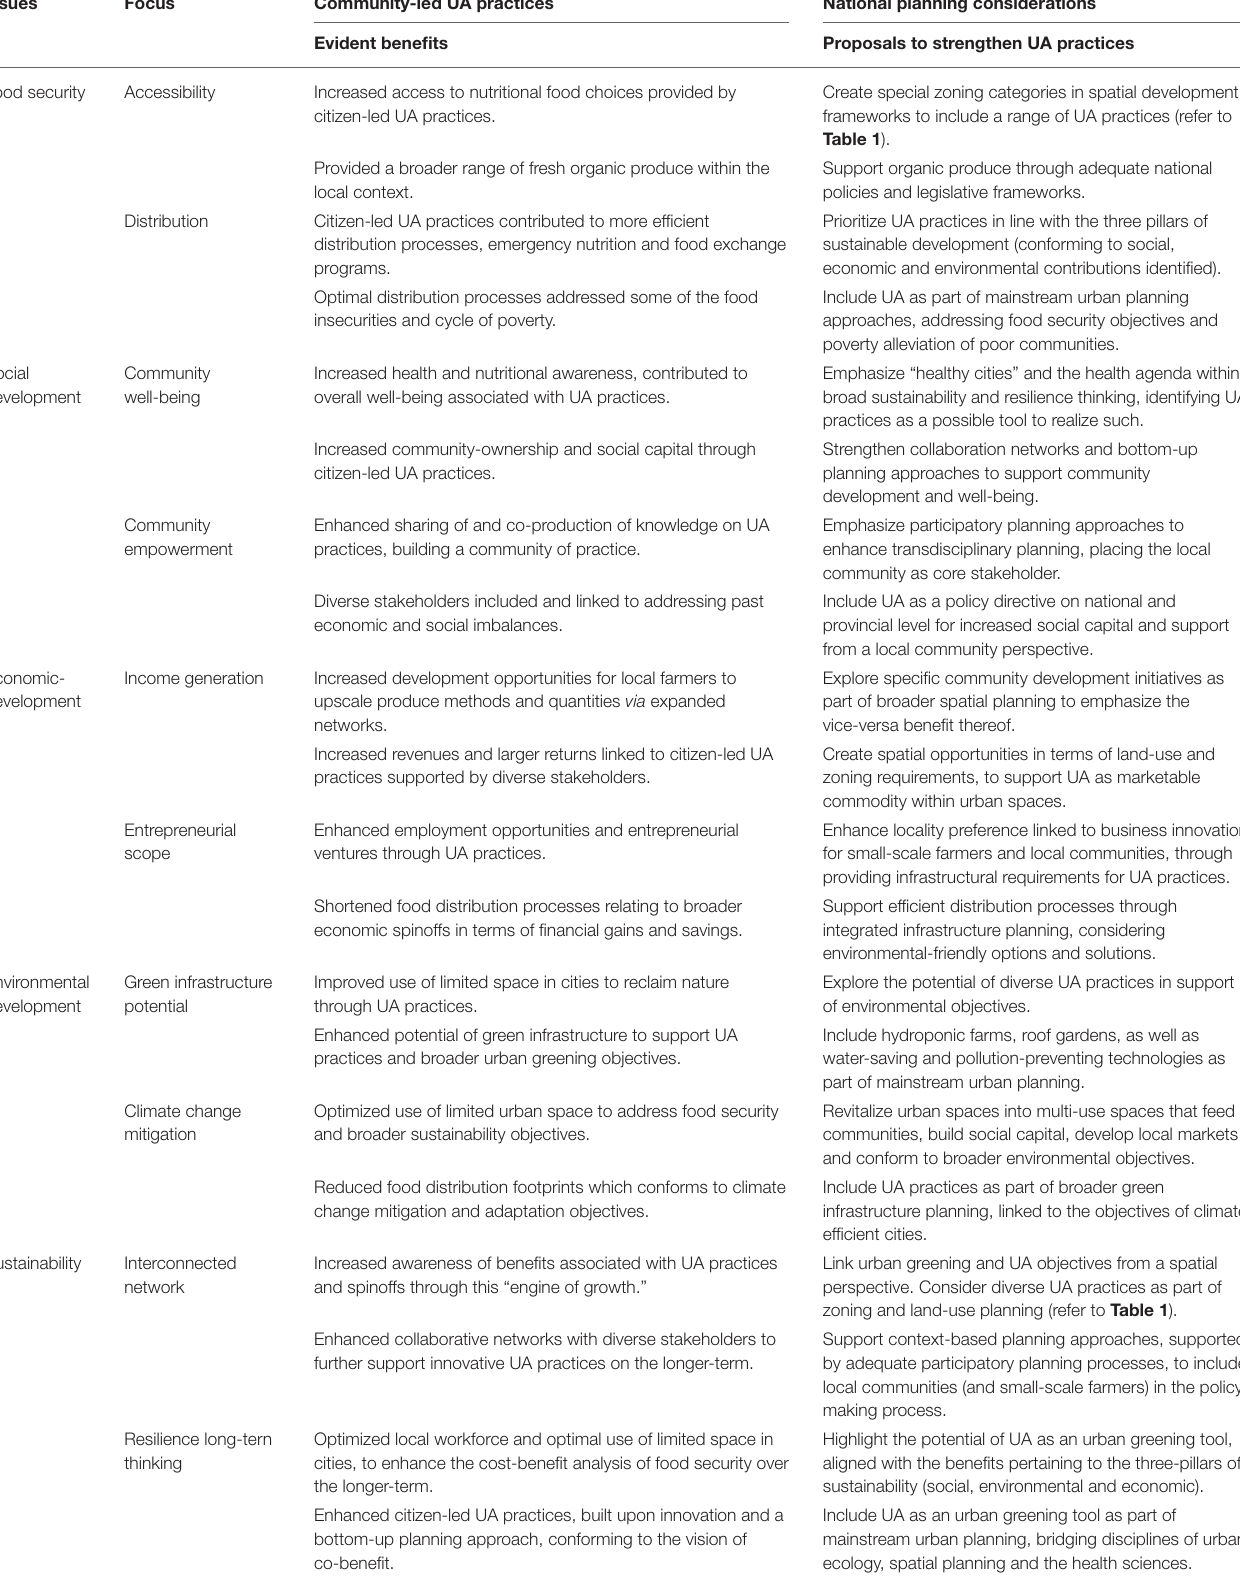
TABLE 5 | Framework for employment of UA as an urban greening tool in South